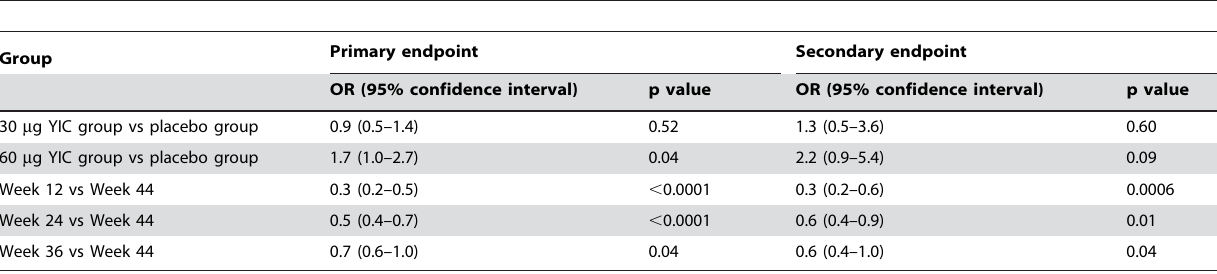
Table 3. Repeated measures analysis for time and group effects controlling by baseline ALT and HBV DNA.